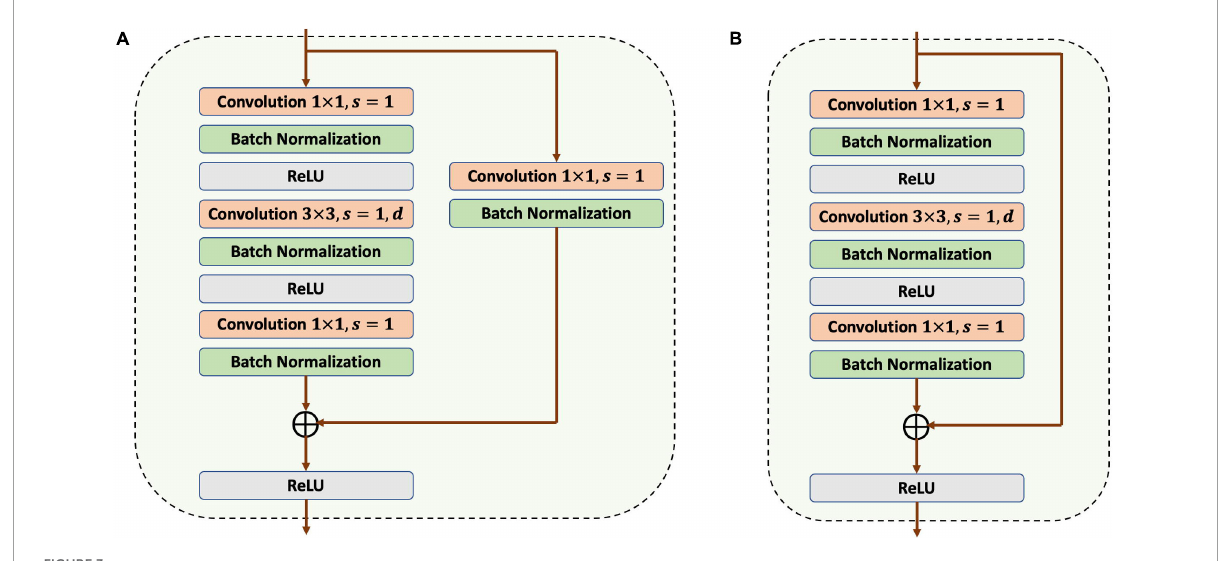
FIGURE3 Framework of two types of bottlenecks. (A) Bottleneck 1. (B) Bottleneck